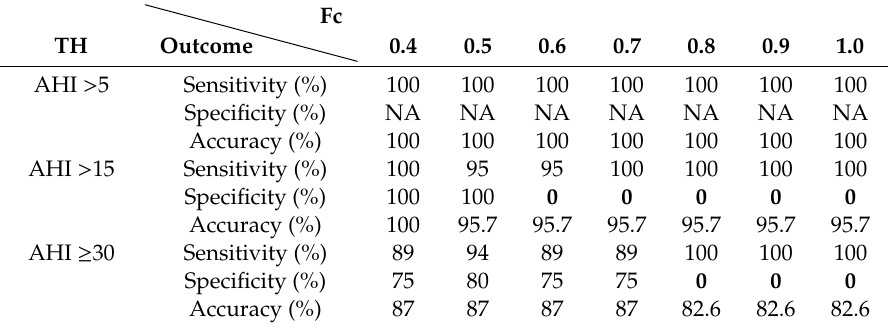
Table 4. Analysis of accuracy detection among apnea-dominant participants.